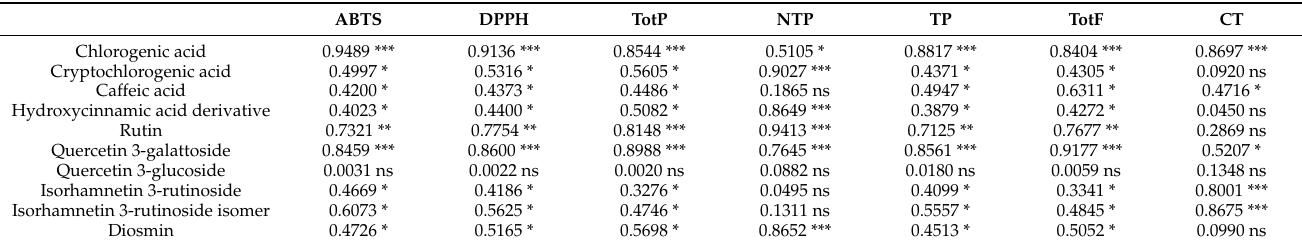
Table 9. Correlations ( R 2 ) established between antioxidant capacity (ABTS, DPPH), total phenolics (TotP), non-tannic phenolics (NTP), tannic phenolics (TP), total flavonoids (TotF), condensed tannins (CT) and individual phenolic compounds in Sulla coronaria shoots. ABTS DPPH TotP NTP TP TotF